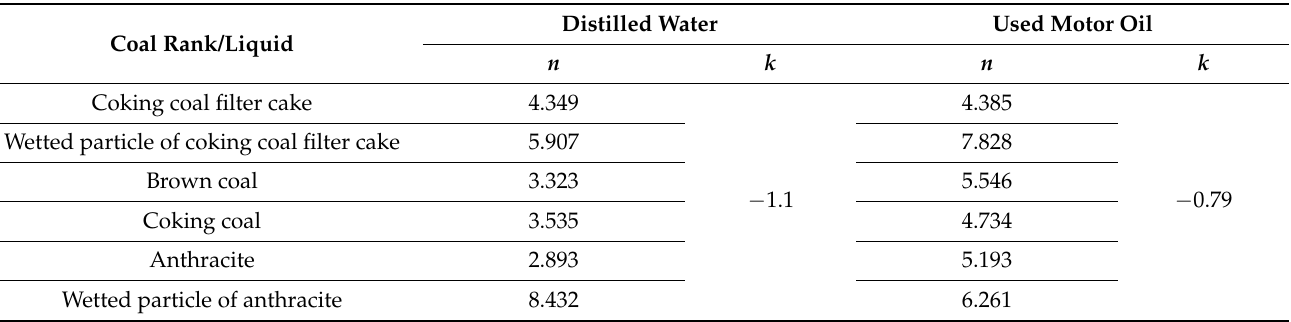
Table 3. Empirical